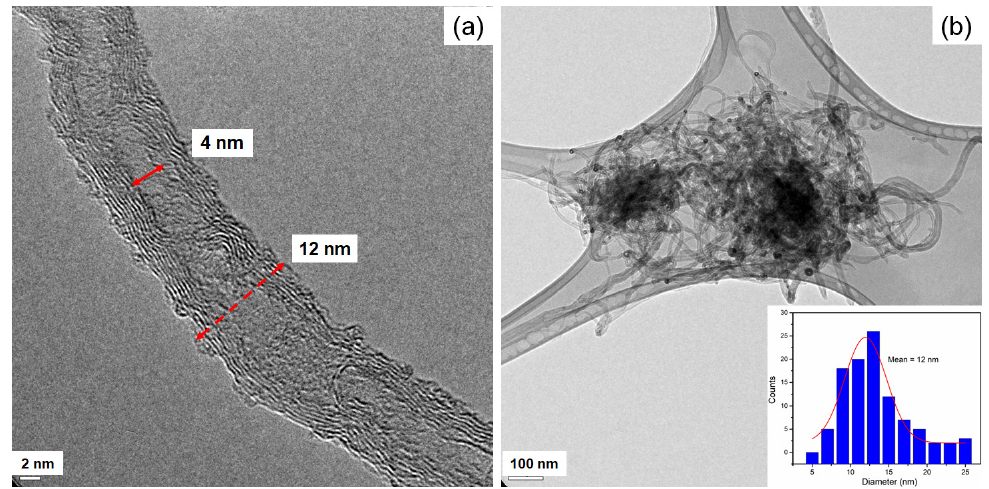
Figure 3. HR-TEM images of SWCNTs. ( a ) Bright-field TEM image showing the inner and outer diameter size of SWCNTs, ( b ) HR-TEM of dispersed SWCNTs. The inset in ( b ) shows the diameter size distribution of SWCNTs.